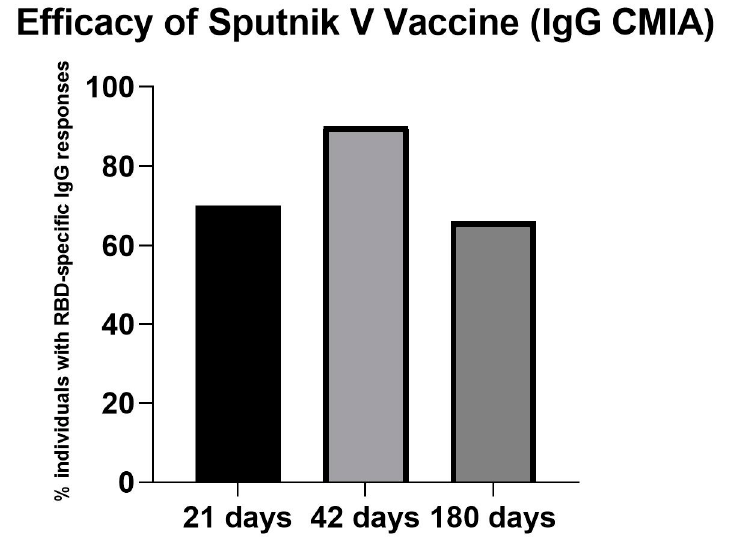
Figure 1. Efficacy of the Sputnik V vaccine as measured by the percentage of individuals displaying RBD-specific IgG responses at days 21, 42, and 180 post-immunizations. These efficacy data were taken only in older adults who had not been previously infected with COVID-19, as detected by SARS-CoV-2 nucleoprotein.